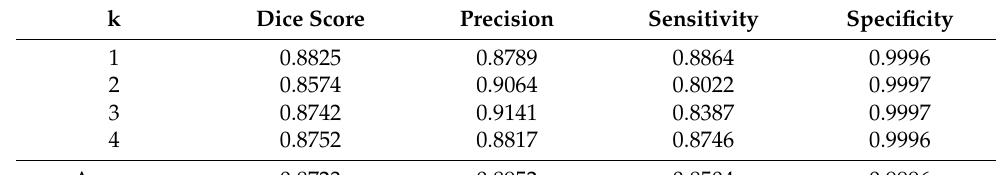
Table 1. Metrics evaluated from models obtained by each iteration of k-Fold.